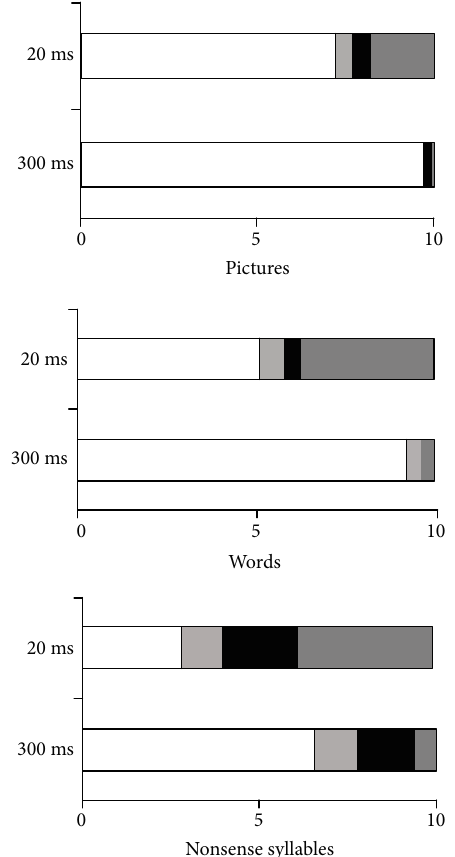
Figure 4: Error patterns in the AD group. AD = Alzheimer ’ s disease. We classi fi ed the error patterns into 4 types (see the text). The presentation times are shown on the y -axis and the total numbers of responses are shown on the x -axis. There were signi fi cant di ff erences between the pattern of responses and the presentation time in pictures ( χ 2 = 239 , p < 0 : 001 ), words ( χ 2 = 129 , p < 0 : 001 ), and nonsense syllables ( χ 2 = 157 , p < 0 : 001